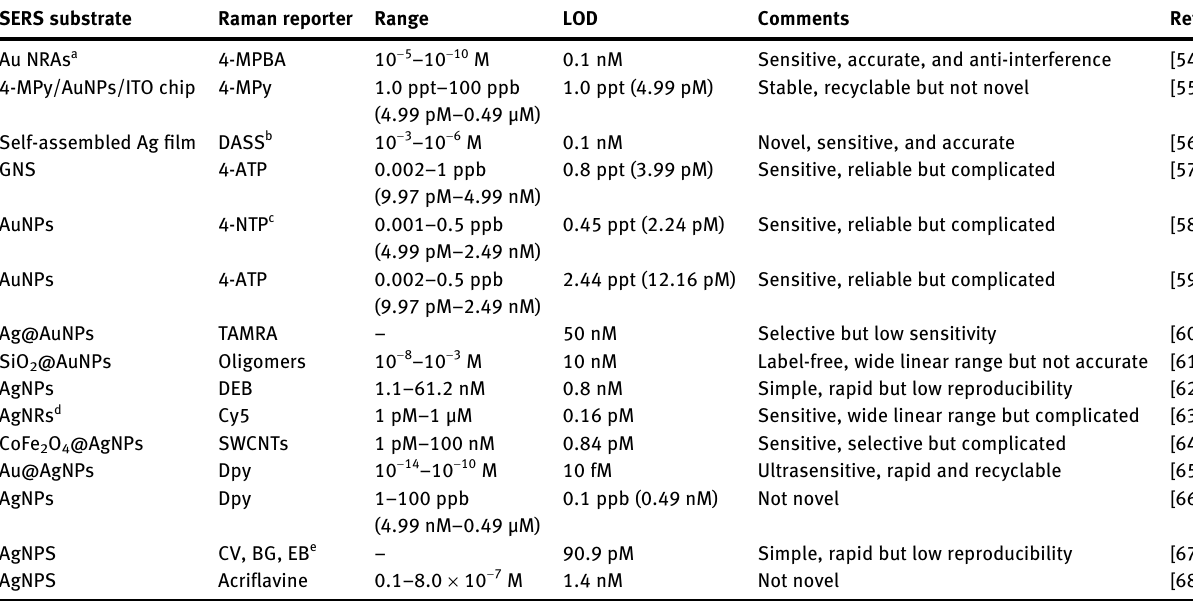
Table  : The methods for detecting mercury ions based on SERS in recent years. SERS substrate Raman reporter Range